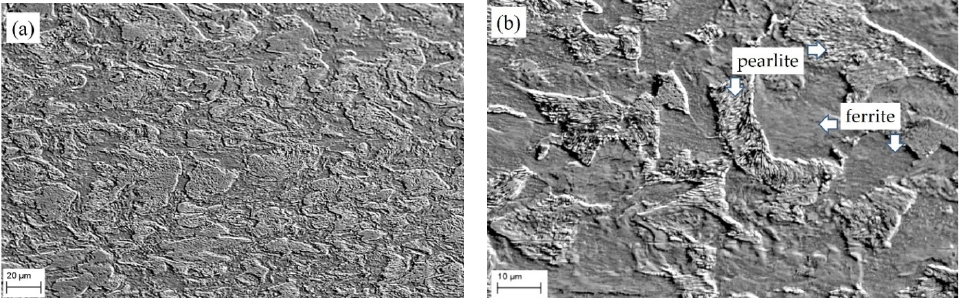
Figure 3. SEM microstructure of 17H1S steel in the AR state at ( a ) low and ( b ) high magnifications.